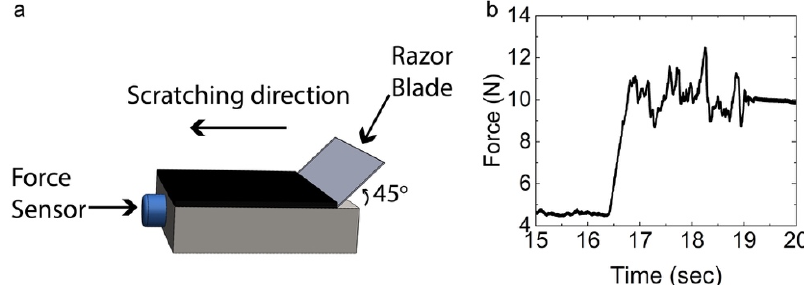
Figure 1. ( a ) Schematic of the scratching setup for testing the adhesion between the CNTs and their steel substrates; ( b ) obtained force-time curve for sample S3.